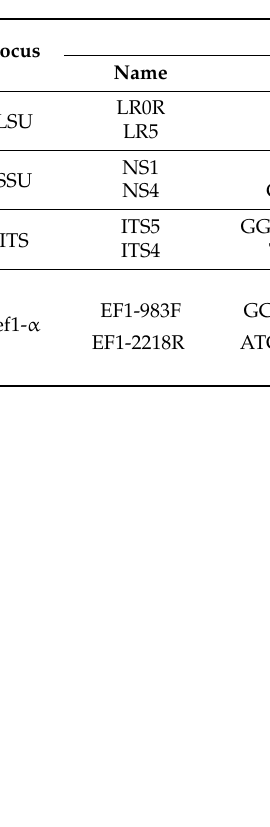
Table 5. Primers and PCR procedures used in this study.